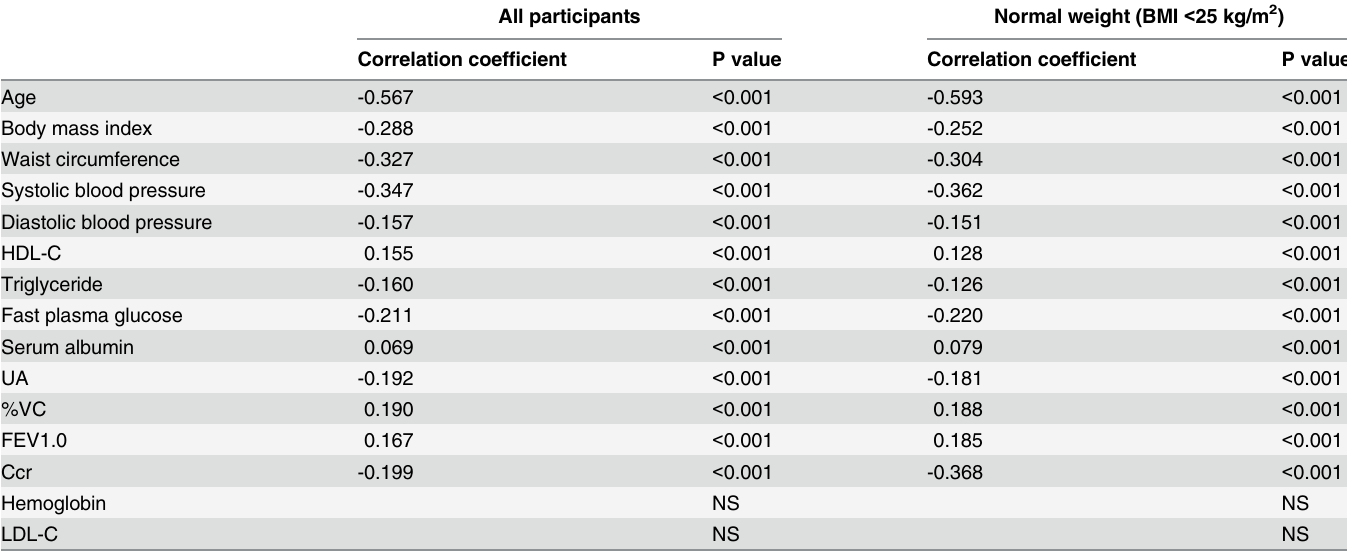
Table 2. Spearman ’ s rank correlation coefficients between abnormal left ventricular myocardial relaxation (LVMR) and various potential risk